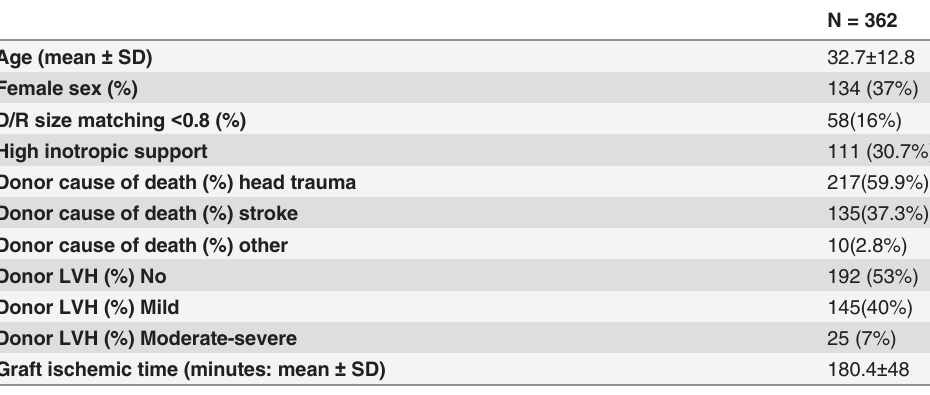
Table 2. Donor and transplant characteristics.